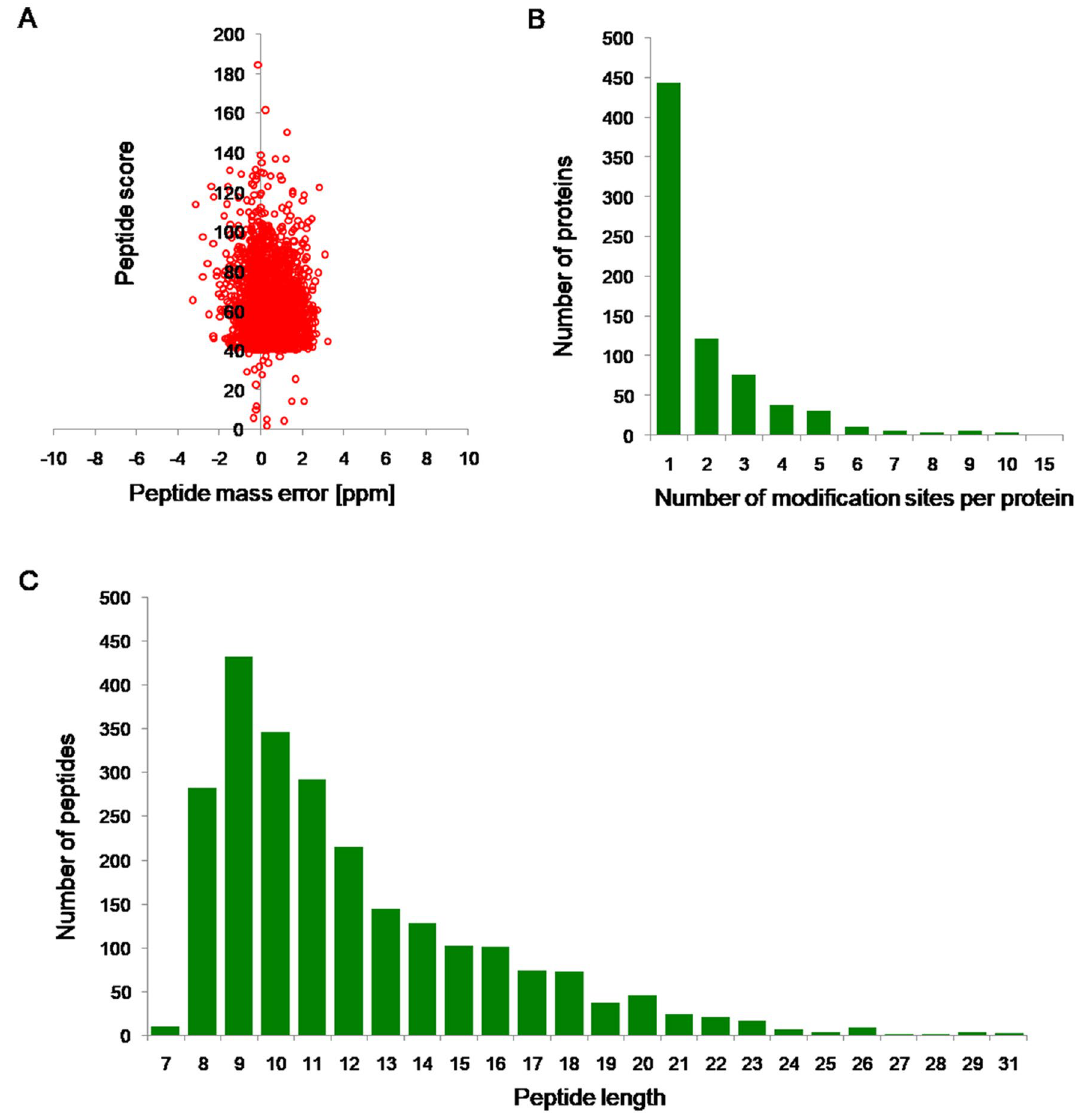
Figure 1. Properties of the identified peptides in C. chloroleuca 67–1. ( A ) Distribution of peptide mass errors. ( B ) Distribution of lysine acetylation (Kac) sites. ( C ) Length of Kac